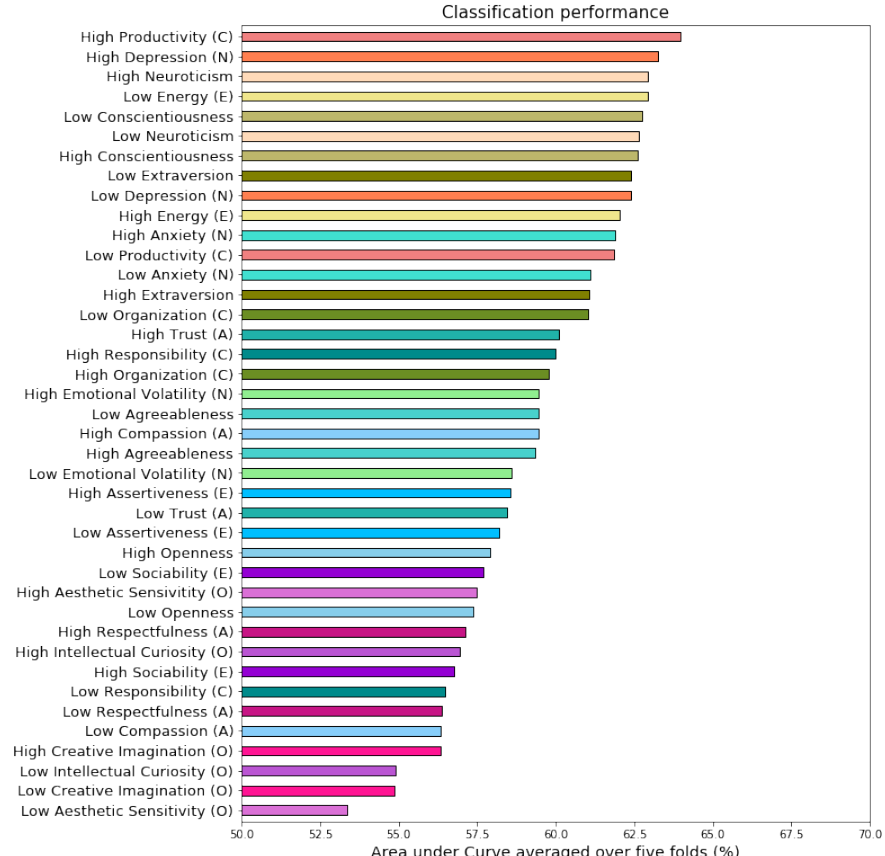
Figure 5. Prediction accuracy of models that classify High or Low levels of personality traits and facets expressed by the AUC averaged over five folds. The personality trait to which each facet belongs, is shown in parentheses (e.g., ‘E’ stands for